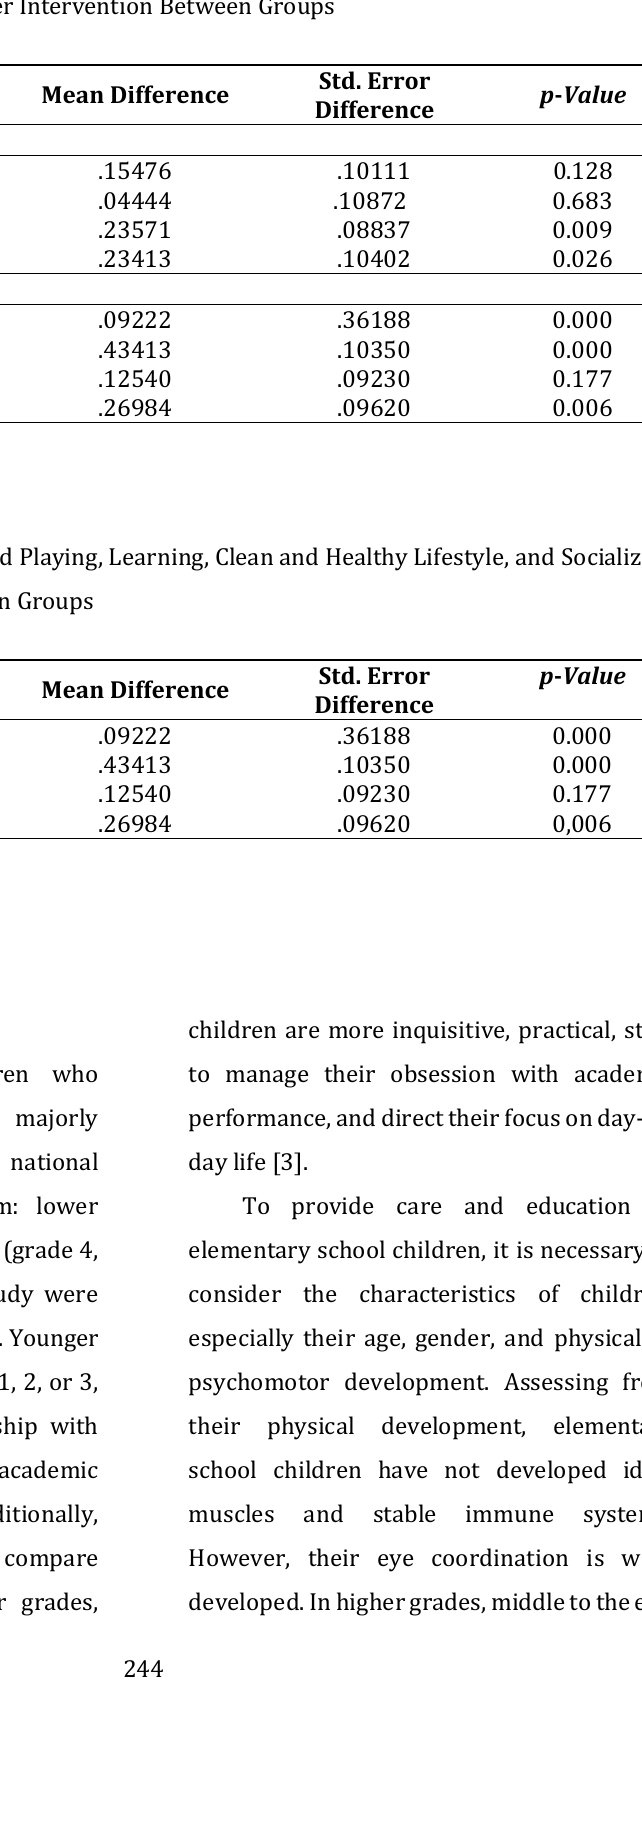
Children’s Adaptation Behavior Toward Playing, Learning, Clean and Healthy Lifestyle, and